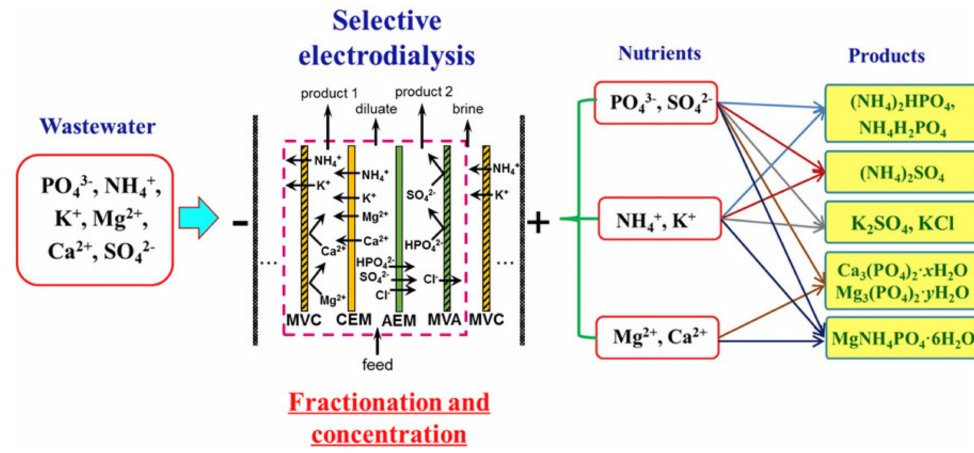
Figure 8. Possible pairwise fractionation and concentration of nutrients from multicomponent solutions using SED. Adapted and modified from